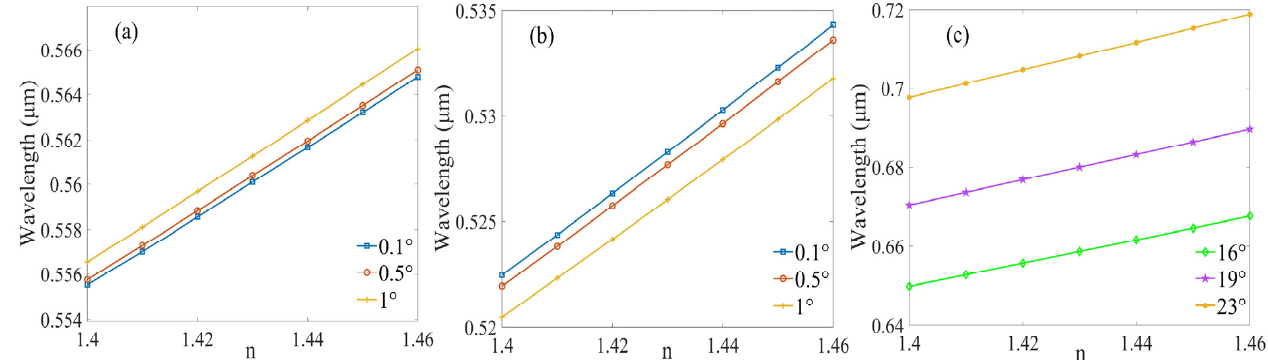
Figure 10. The center wavelength of the resonance modes as functions of the refractive index n 2 of the surrounding medium around ( a ) at Γ BIC I and ( b ) at Γ BIC II at incidence angles of 0.1°, 0.5°, and 1°, and ( c ) at o ff Γ BIC at incidence angles of 16°, 19°, and 23°, respectively. When n 2 increases from 1.4 to 1.46 in steps of 0.01, the other structural parameters are n 1 = 2.02, a = 0.336 µm, H = 0.18 µm, L 1 = L 2 = 0.2 µm, W 1 = W 2 = 0.1 µm.